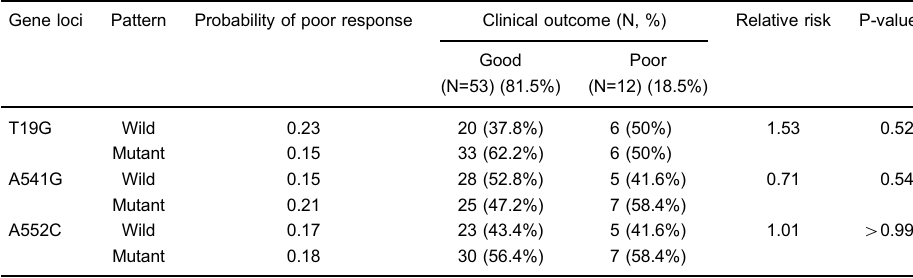
Table 3. Relative risk of a poor clinical outcome in various gene polymorphisms. Gene loci